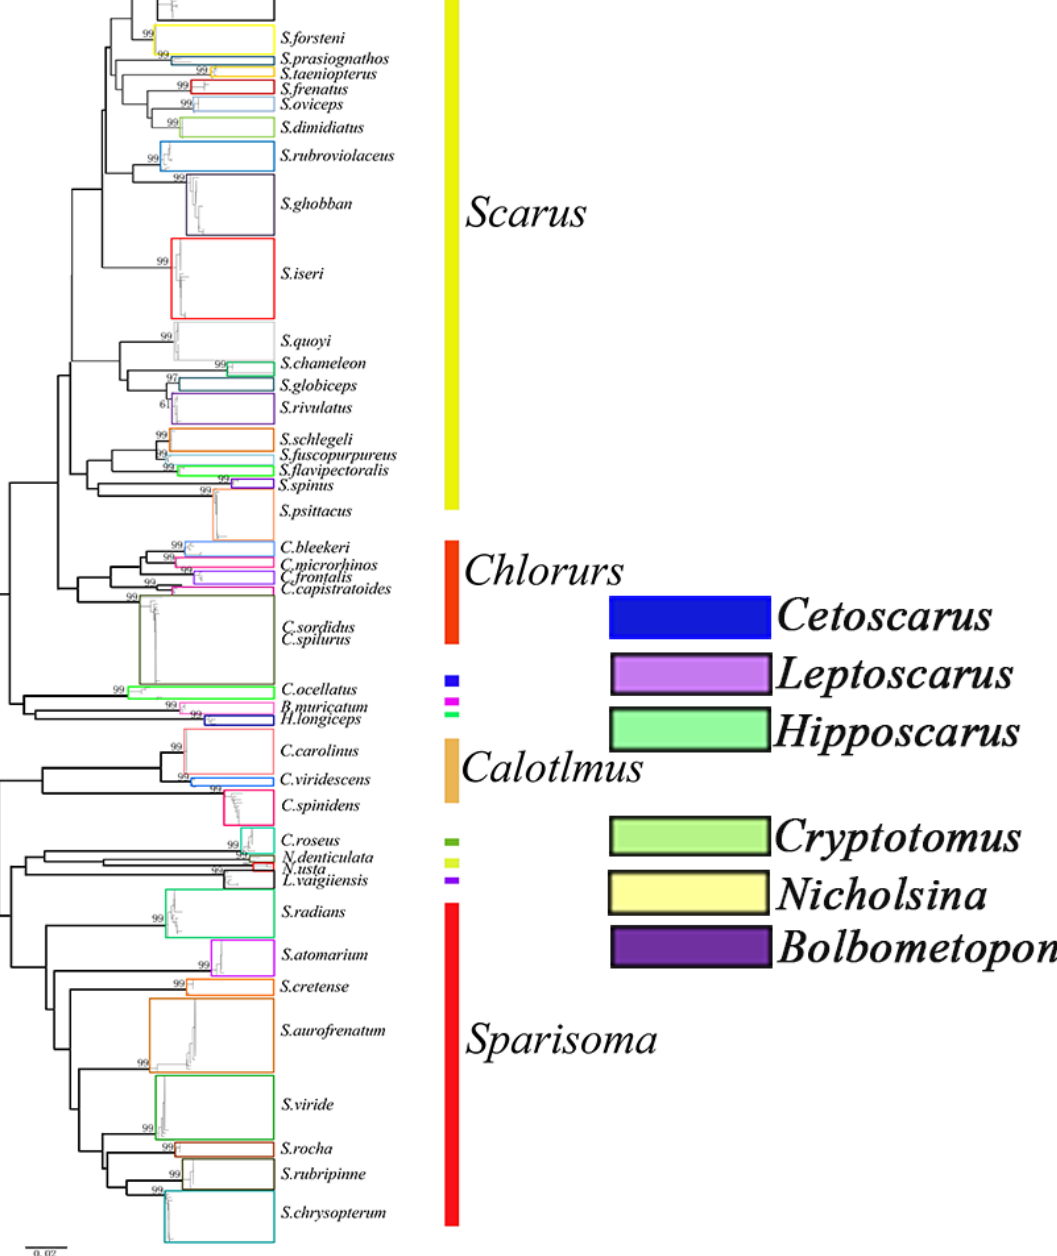
Figure 2. NJ tree resulting from analysis of the CO I gene for Scaridae species Bootstrap vaues Higher than 50% based on 1000 replicates are shown on the branches. The scale represents a genetic distance of 0.01 per million years.